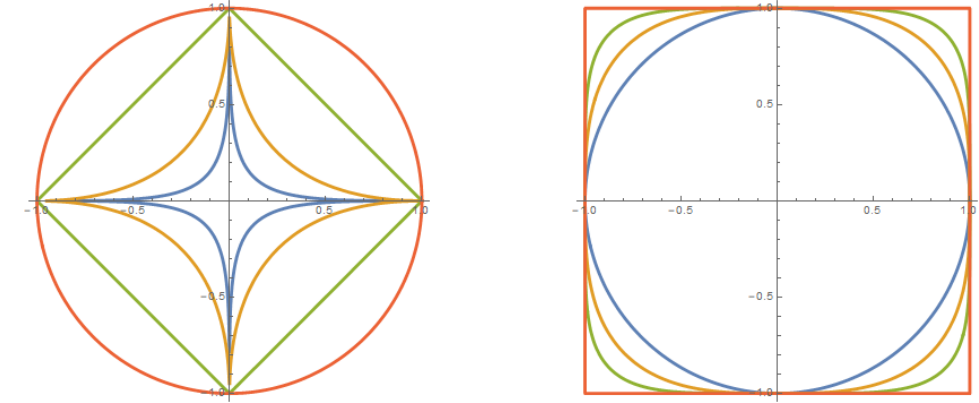
Figure 4: model class 3. left: contour curves of h for value 1 and p ∈ { 1 3 , 1 2 , 1, 2 } , right: p ∈ { 2, 3, 4, 5 }